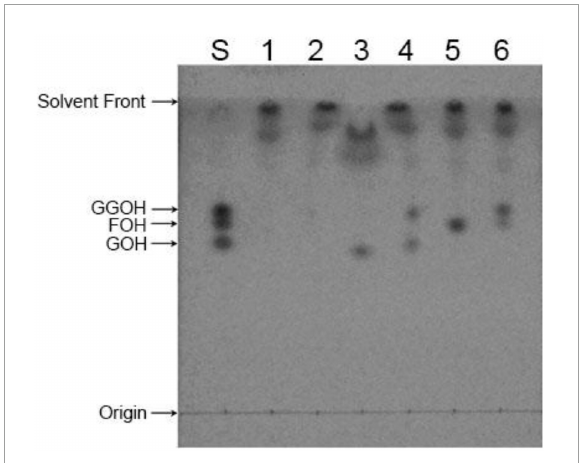
FIGURE5 TLC analysis of in vitro enzymatic activity reaction products of CrtE. S: GOH, FOH, and GGOH standard mix; 1, 3, and 5: enzymatic reaction system without CrtE protein using DMAPP, GPP, and FPP as substrates, respectively; 2, 4, and 6: enzymatic reaction system containing CrtE protein with DMAPP, GPP, and FPP as substrates,